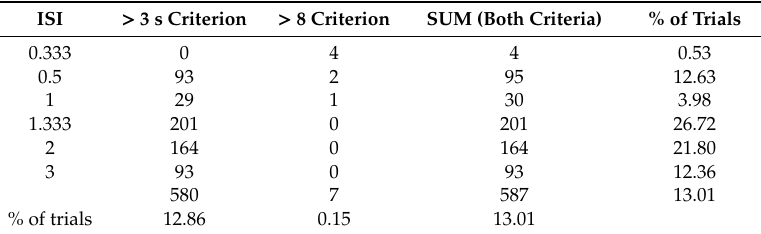
Table A2. Excluded trials per